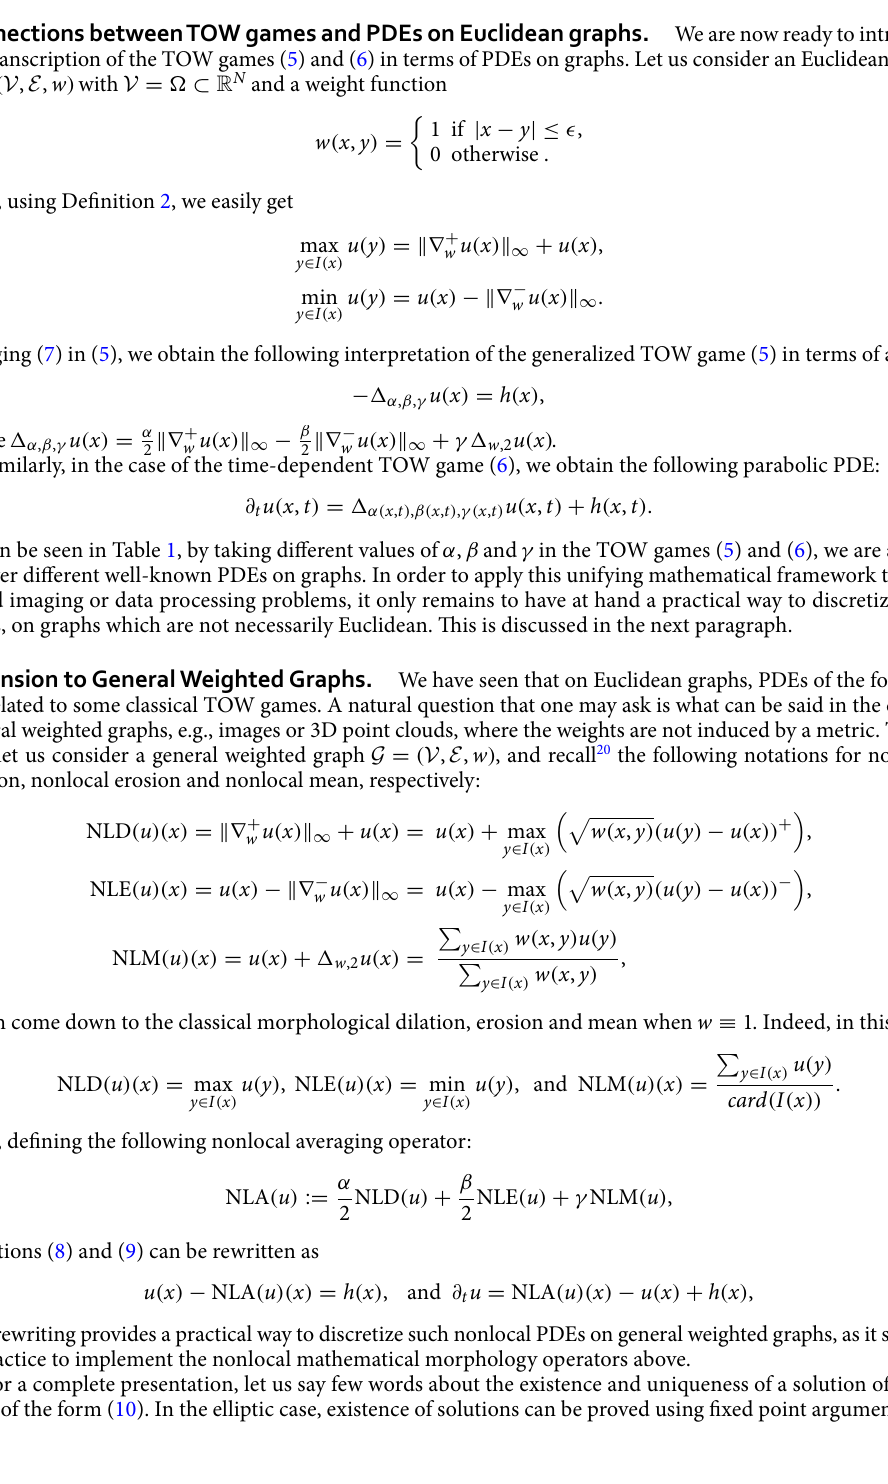
TOW game parameters Elliptic PDE Parabolic